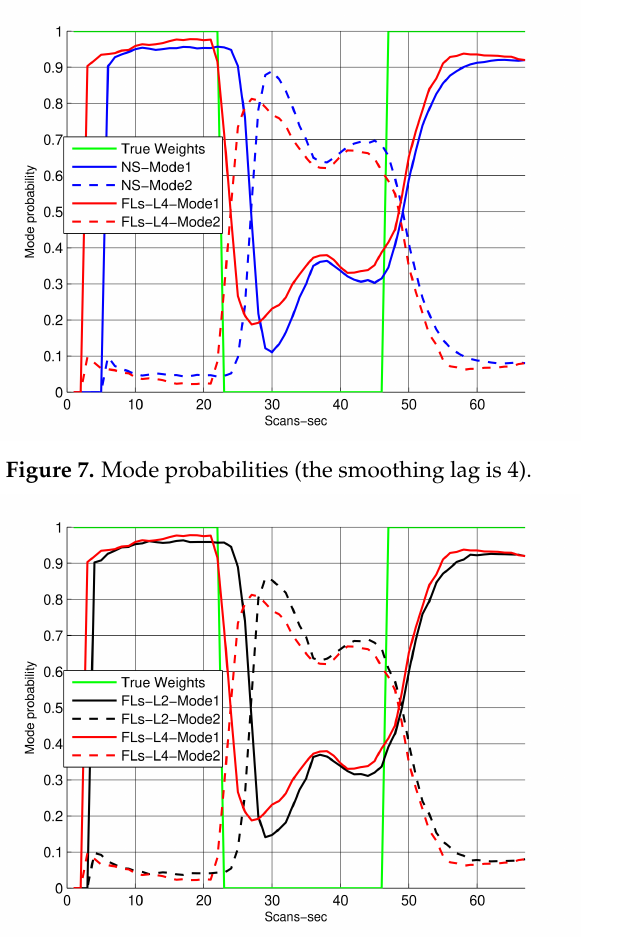
Figure 8. Mode probabilities for lag sizes 2 and 4.